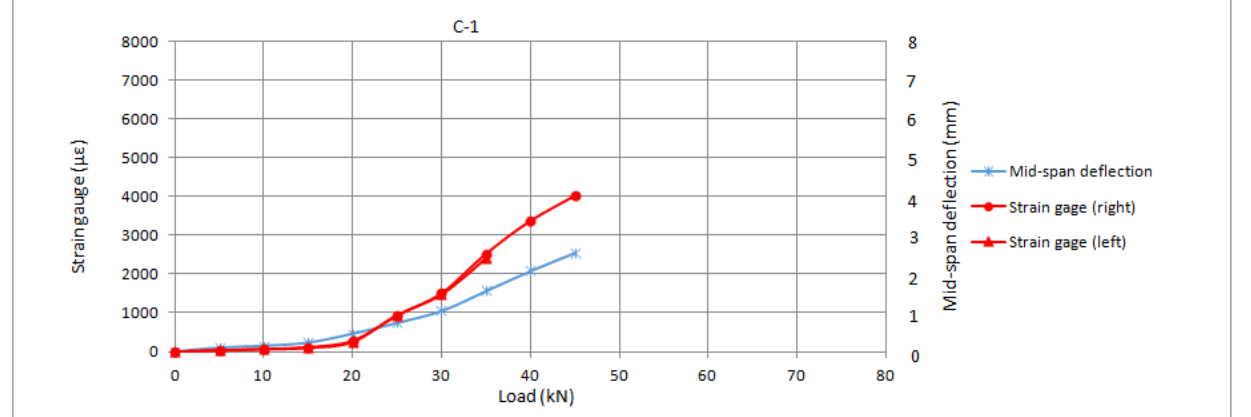
Figure 7. Load-slip response of the control series (C series).